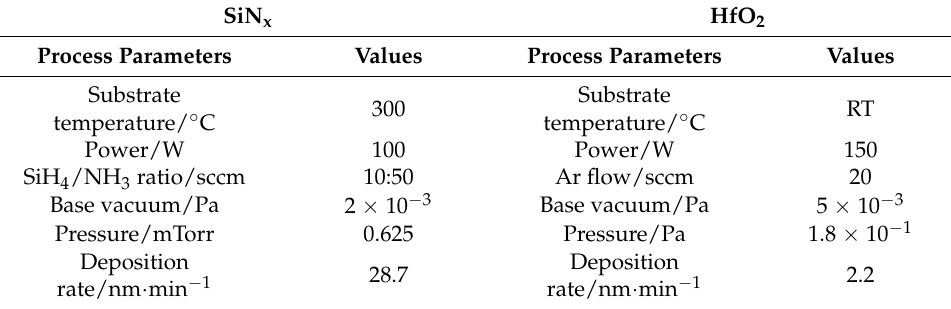
Figure 1. The process of stacked dielectrics a-IGZO TFT. Table 1. The deposition parameters of SiN x and HfO 2 dielectrics.